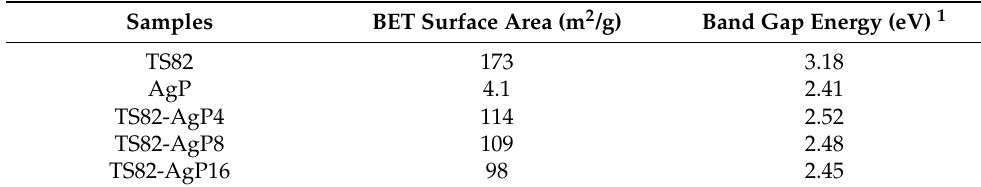
Figure 4. ( a ) Optical absorption spectra of different samples and ( b ) Plot of (Ah v ) 1/2 against the incident photon energy (eV) calculated from the absorption spectra plotted in ( a ). Table 1. BET surface area and band gap determination of different composites.